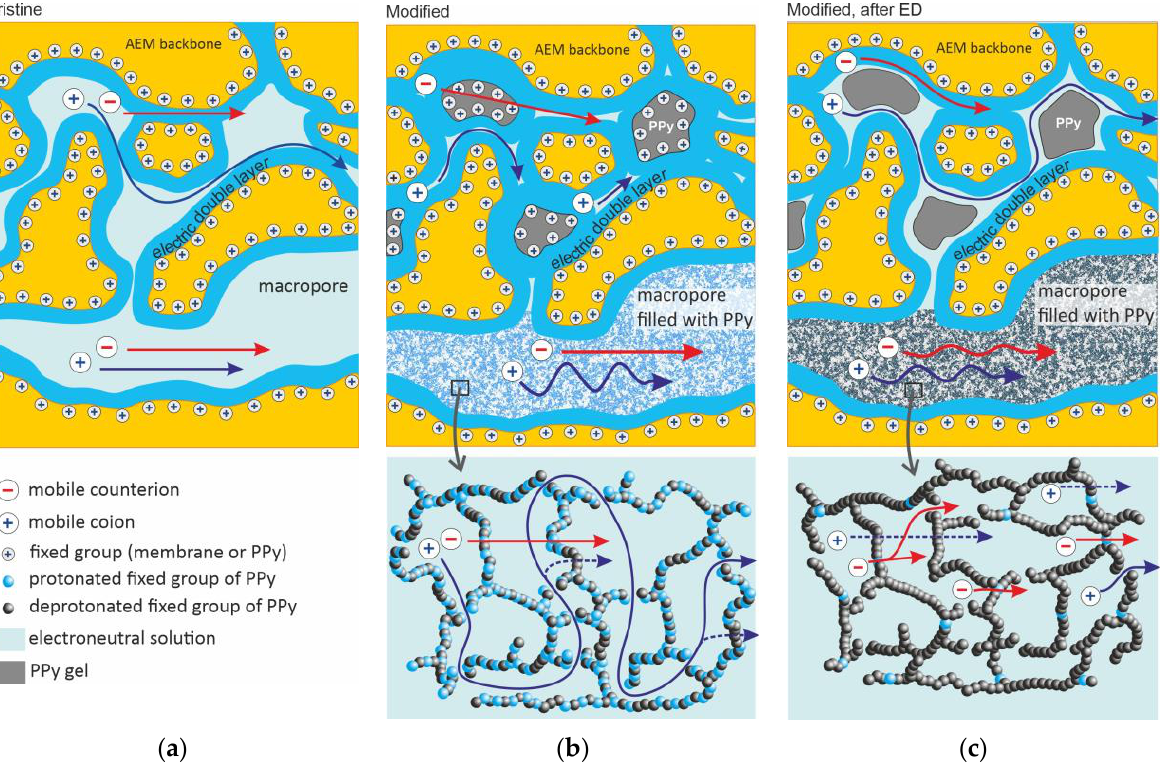
Figure 5. Schematic representation of the changes in studied membrane structure at different stages of its treatment: ( a ) the pristine MA-41 membrane, ( b ) the modified membrane, ( c ) the modified membrane used in an ED process. The membrane structure is presented in accordance with modern concepts [58,60,61]: mesopores (ion clusters) are connected to each other by narrower ion-conducting channels; the macropores are due to structural defects including the gaps between ion-exchange material and non-conductive fillers, such as fibers of reinforcing cloth [40]. The arrows show ion pathways during salt diffusion through the